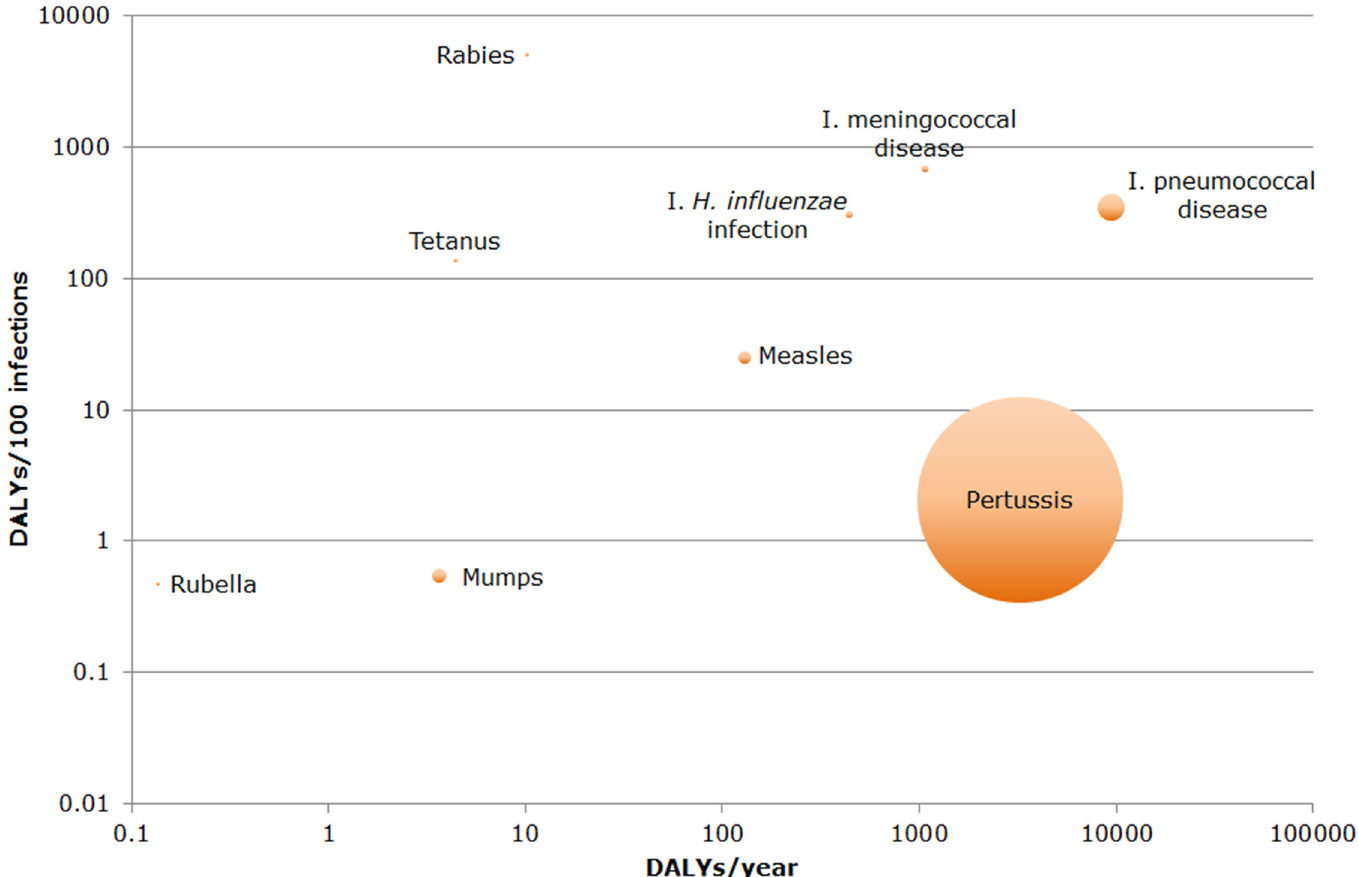
Fig 4. Ranking of vaccine-preventable diseases by disease burden at population/individual level in the Netherlands in 2007 – 2011. Diphtheria and poliomyelitis could not be included because there were no cases reported in this period. The area of each bubble is proportional to the average number of estimated annual cases (50 cases were added to each bubble for visibility reasons). Both axes are on a logarithmic scale. (DALY = Disability-Adjusted Life Years, population level = number of DALYs/year, individual level = number of DALYs/100 infections, I. = invasive).